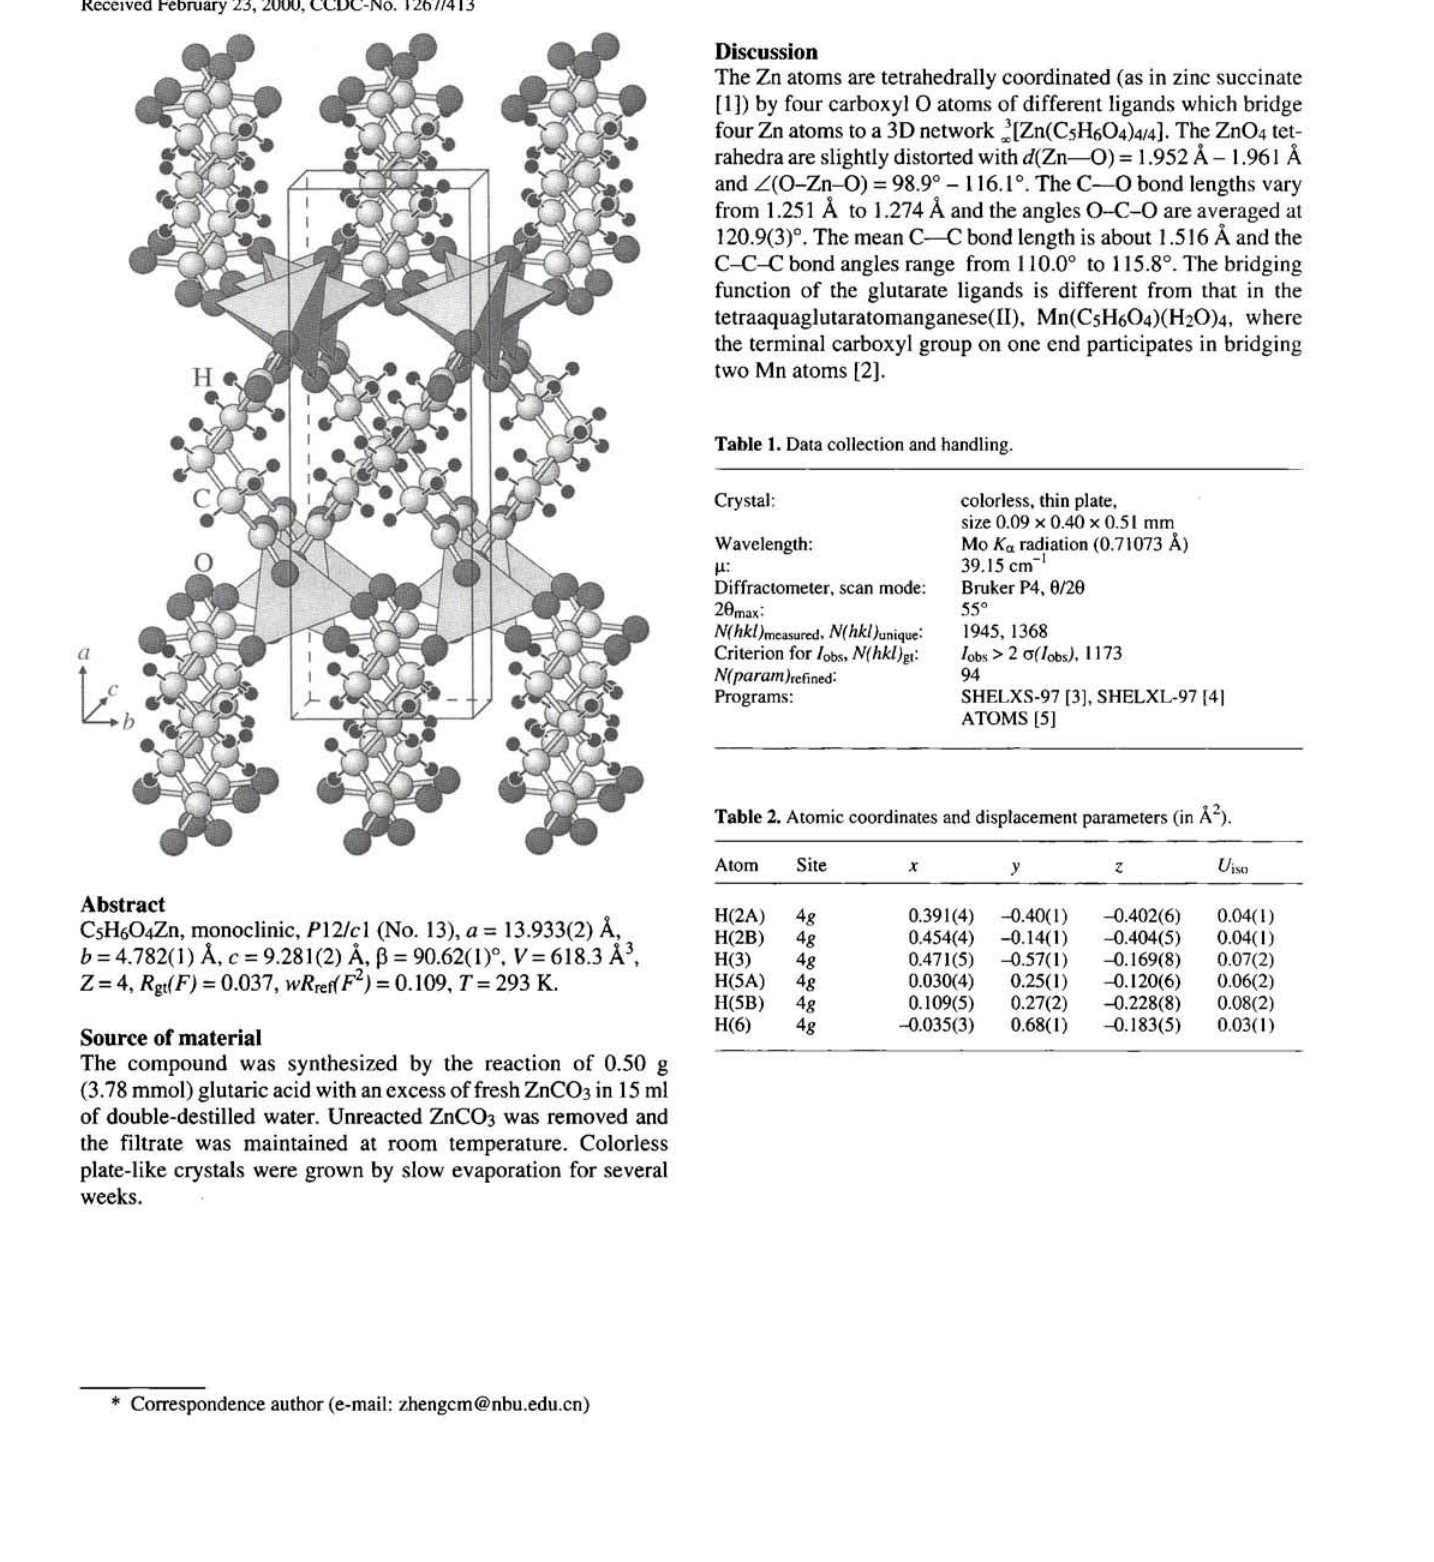
Table 1. Data collection and handling.